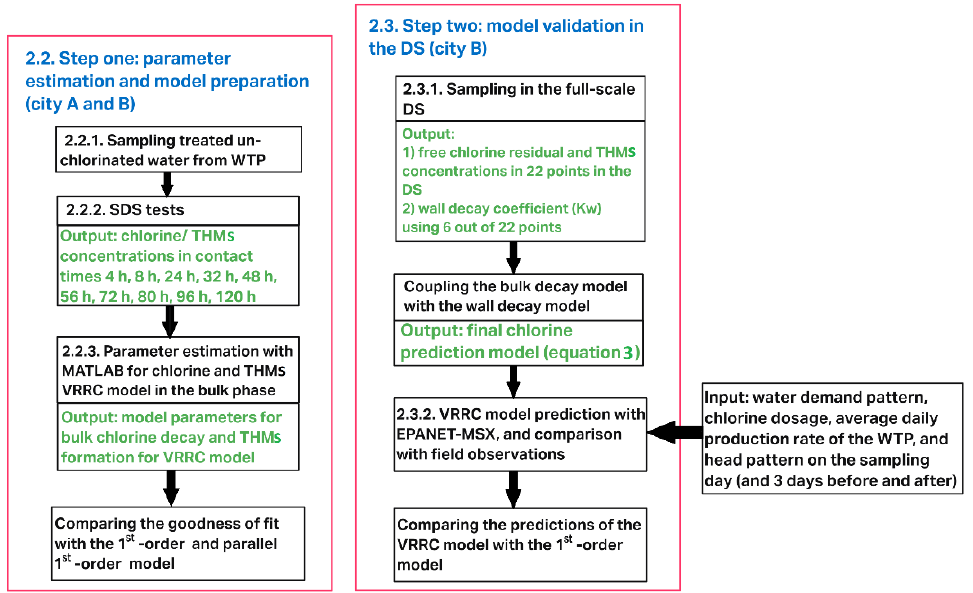
Figure 3. Overall methodological approach for parameter estimation and model validation in the DS.